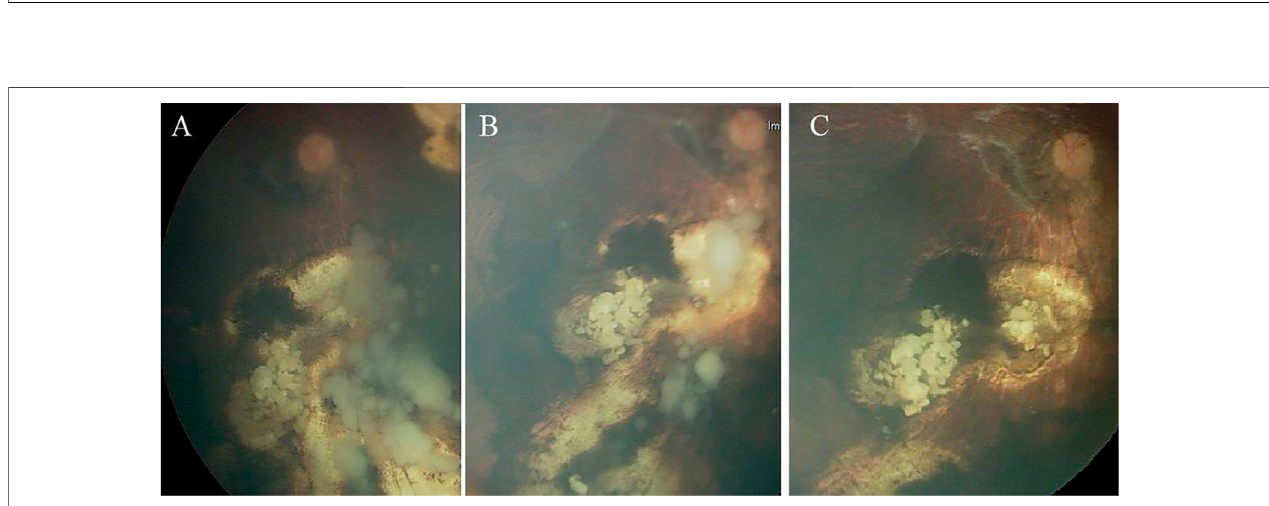
FIGURE2| Treatment response ofvitreous seedingtointravitreal melphalaninjection; (A) massivecloud ofvitreous seeds thatregressed partiallyafter 3injections (B) and totally disappeared after total of 6 injections (C) . This shows type 0 pattern of regression where vitreous seeds disappeared completely.